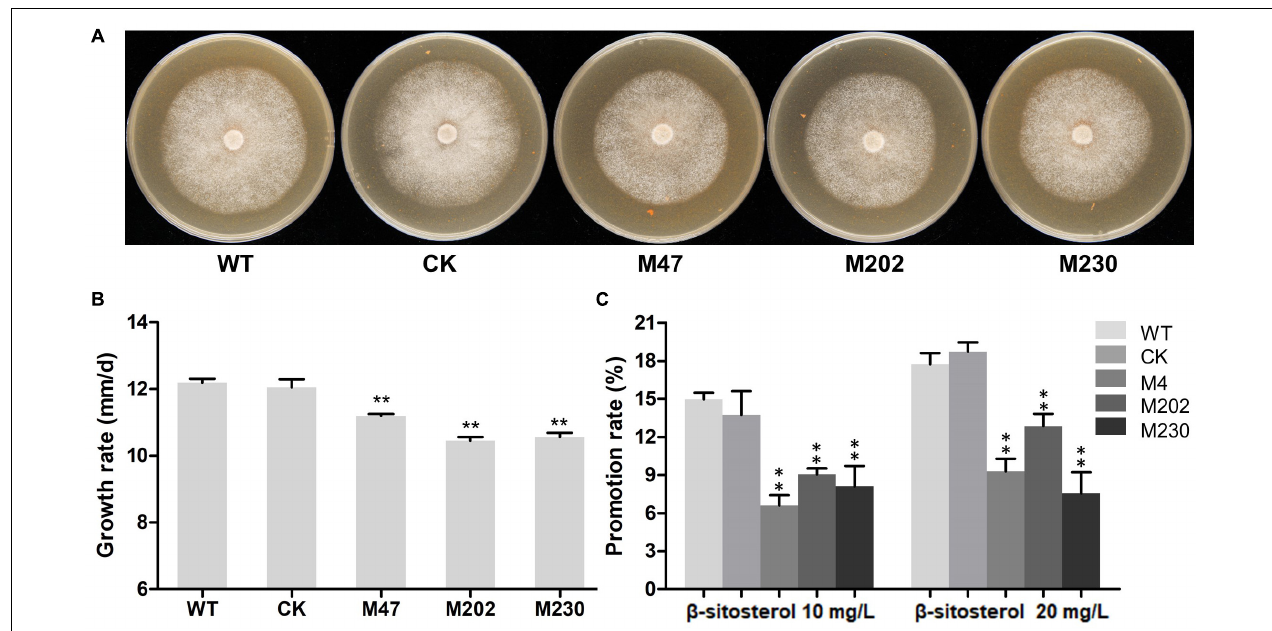
FIGURE 4 | Growth rate and β -sitosterol utilization of WT, CK, and the (cid:49) plcb5l1 mutants. (A) Colonies of three independent (cid:49) plcb5l1 mutants (M47, M202, and M230), WT and CK strains were cultured on CJA medium at 25 ◦ C in the dark for 5 days. (B) Growth-rates were measured on CJA medium. (C) Promotion ratio (%) of WT, CK, and (cid:49) plcb5l1 mutants under the condition of Plich medium adding 10 mg/L or 20 mg/L β -sitosterol. The values are mean ± SD ( n = 9). The data were statistically analyzed with Duncan’s Multiple Range Test method, with significant differences defined as ** p <